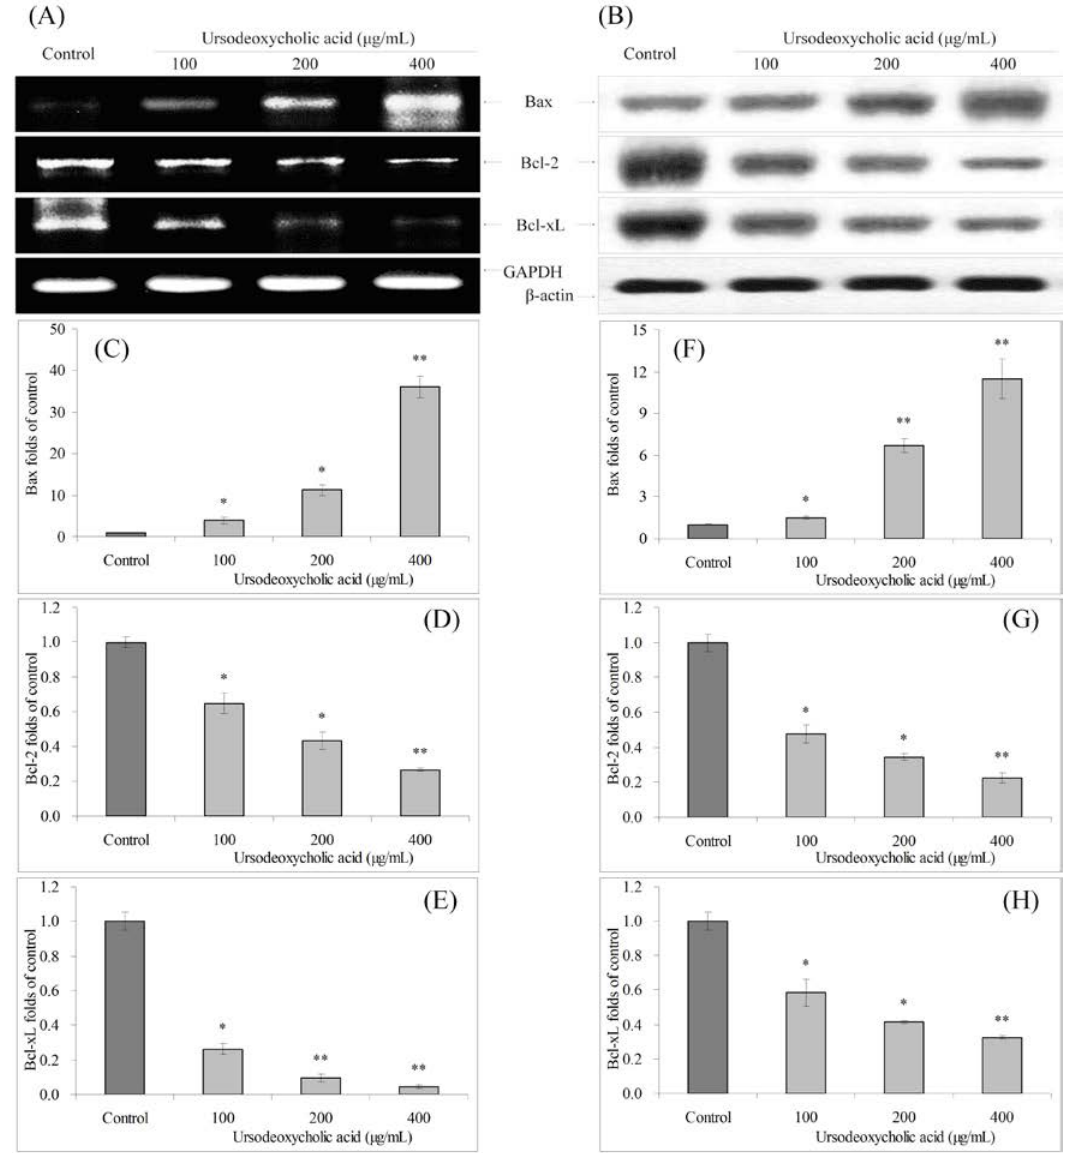
Figure 4. Effects of ursodeoxycholic acid (UDCA) on the mRNA ( A ) and protein ( B ) expression of Bax, Bcl-2 and Bcl-xL in human oral squamous carcinoma HSC-3 cells. Fold-ratio: gene expression/GAPDH (β-actin) × control numerical value (control fold ratio: 1); ( C ), Bax mRNA expression fold over control; ( D ), Bcl-2 mRNA expression fold over control; ( E ), Bcl-xL mRNA expression fold over control; ( F ), Bax protein expression fold over control; ( G ), Bcl-2 protein expression fold over control; and ( H ), Bcl-xL protein expression fold over control. * Mean values are significantly different from control ( p < 0.05) and ** mean values are significantly different from control ( p <